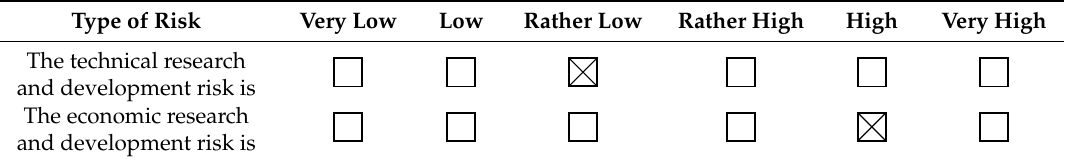
Table 1. Current development stages of Direct Air Capture (DAC) according to their Technology Readiness Level (TRL) (own composition, based on [25,54–57]; boxes are ticked for all TRLs given in the different sources analyzed).